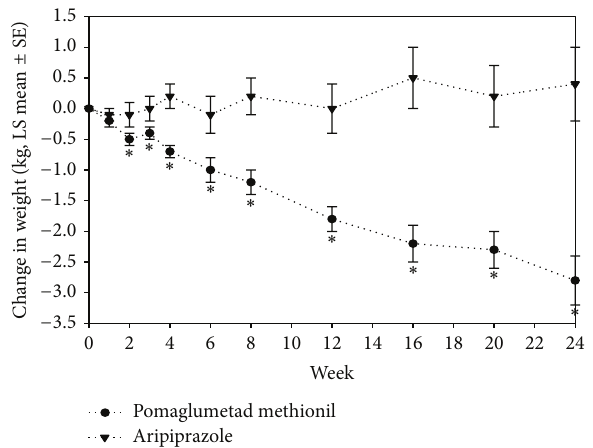
Figure 3: Least-squares mean change of the weight from mixed-effects model repeated measures among intent-to-treat (ITT) patients with schizophrenia in pomaglumetad methionil ( 𝑁 = 511 ) and aripiprazole ( 𝑁 = 161 ) treatment groups for 24 weeks of double-blind treatment. ∗ 𝑃 ≤ 0.05 . 𝑃 values are from type III tests of LS mean differences between treatments at each visit from MMRM. LS mean: least-squares means, MMRM: mixed-effects model with repeated measures, and SE: standard error.